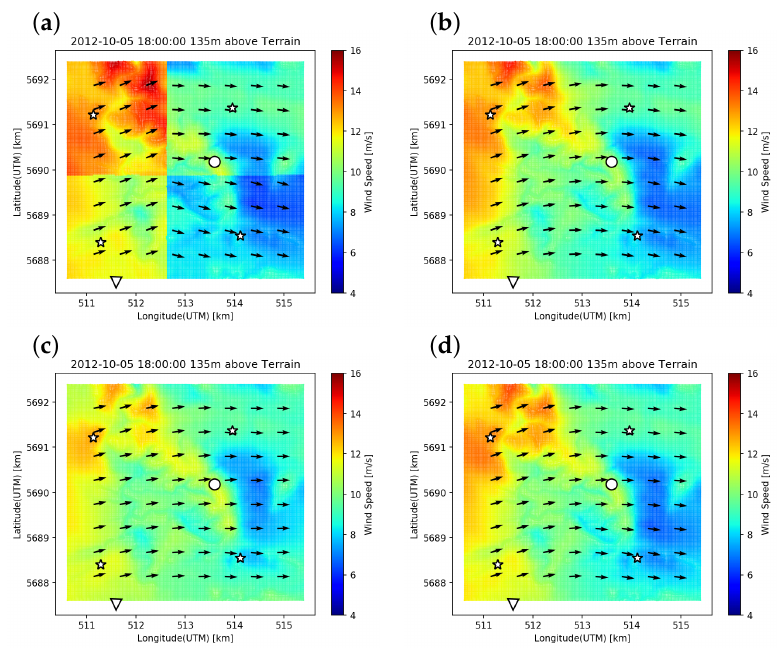
Figure 7. Comparison between no interpolation ( a ), bi-linear method (BILIN) ( b ), inverse distance weighting (IDW) ( c ) and squared inverse distance weighting (ISDW) ( d ) interpolation schemes described in Section 2. The stars represent the reference positions, e.g., meso-scale grid cells. Metmasts at circle (MM200) and triangle (MM140). Neutral stratification